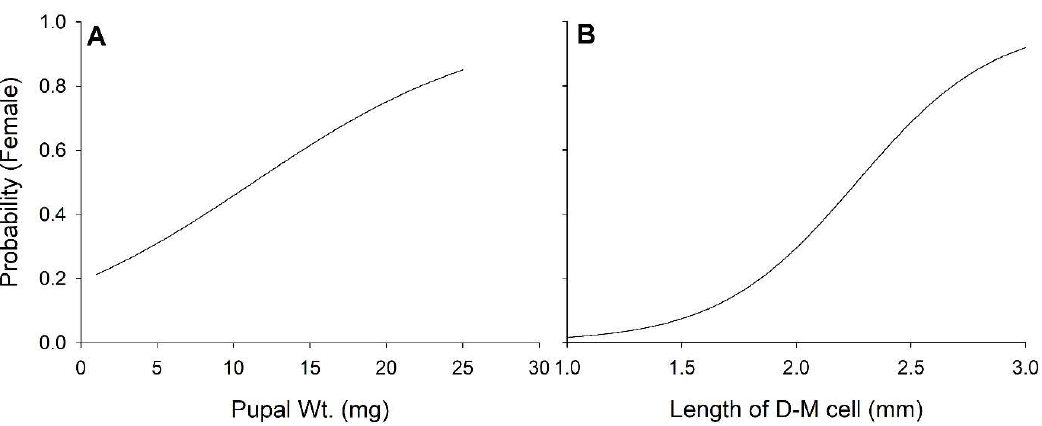
Figure 6. Relationship between size, pupal weight ( A ) and length of discal-medial wing cell ( B ), and sex.